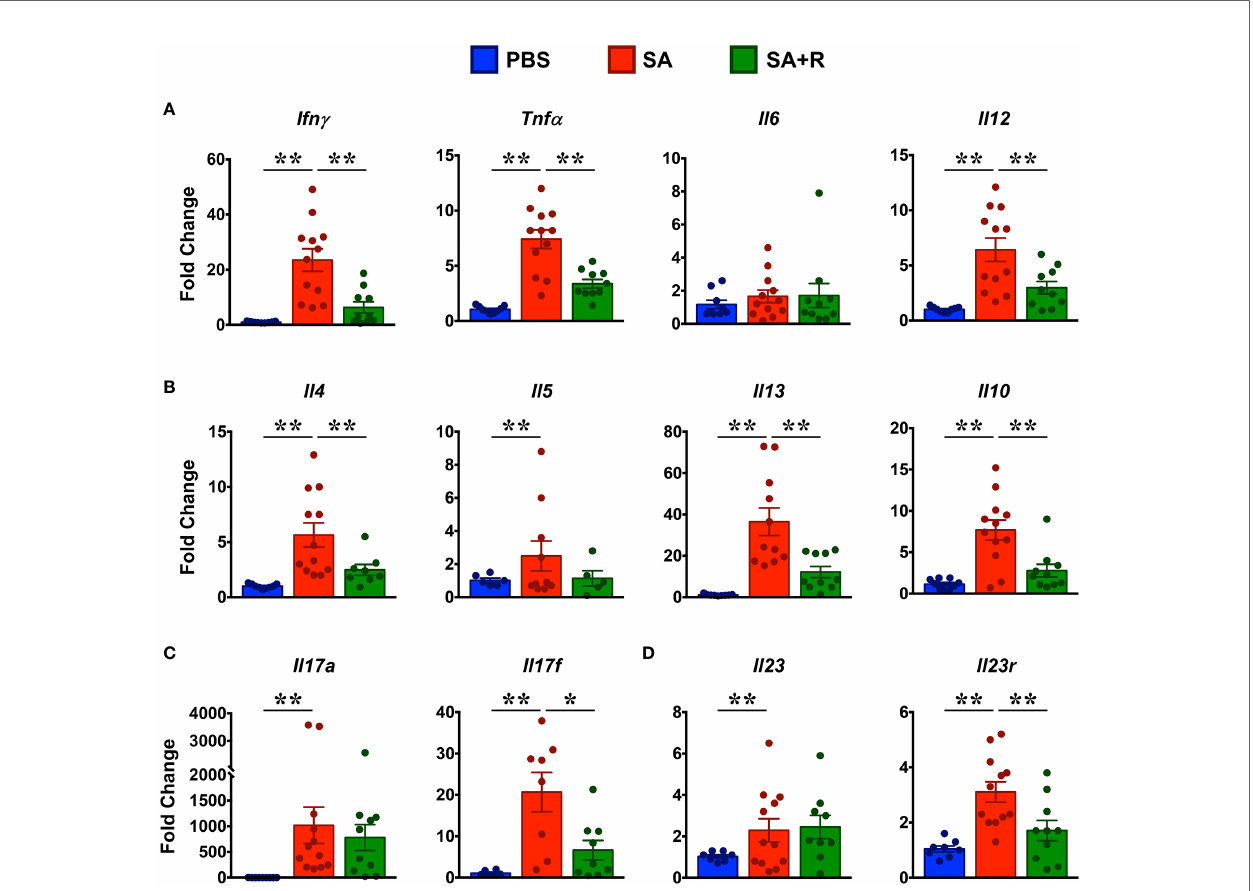
FIGURE 6 | Ruxolitinib targets gene expression of several lung cytokines in SA mice. (A – D) Lungs of control, SA and SA+R mice were analyzed for gene expression of (A) Th1 ( Ifn g ) and pro-in fl ammatory cytokines ( Tnfa, Il6, Il12) , (B) T2 cytokines ( Il4, Il5, Il13 and Il10 ), (C) IL-17 family of cytokines ( Il17a and Il17f ),and (D) Il23 and Il23r . Data is presented as mean fold change ± SEM and is pooled from 3 independent experiments with a total of 8-12 mice per cohort. Statistical signi fi cance was determined by using Student ’ s unpaired t test with Welch ’ s correction. *p ≤ 0.05, **p ≤